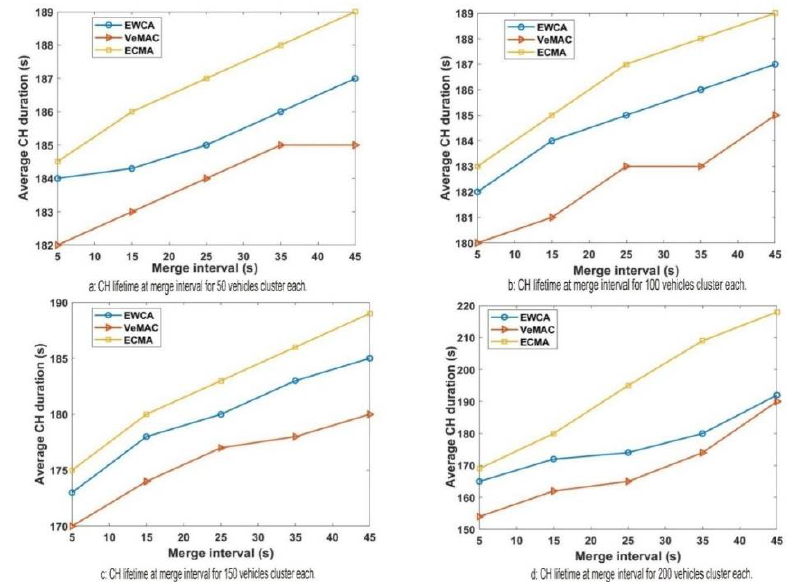
Figure 7. CH lifetime and it influence on Mw.